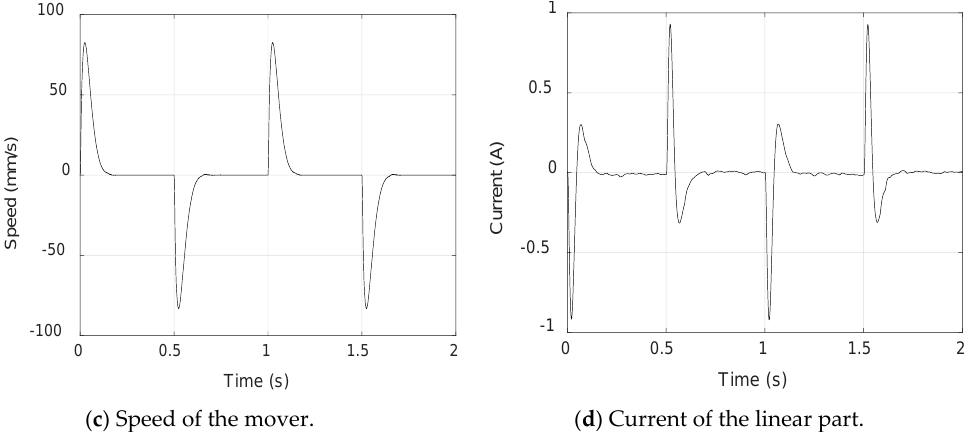
Figure 17. Position responses of the motor under a rectangular wave reference.